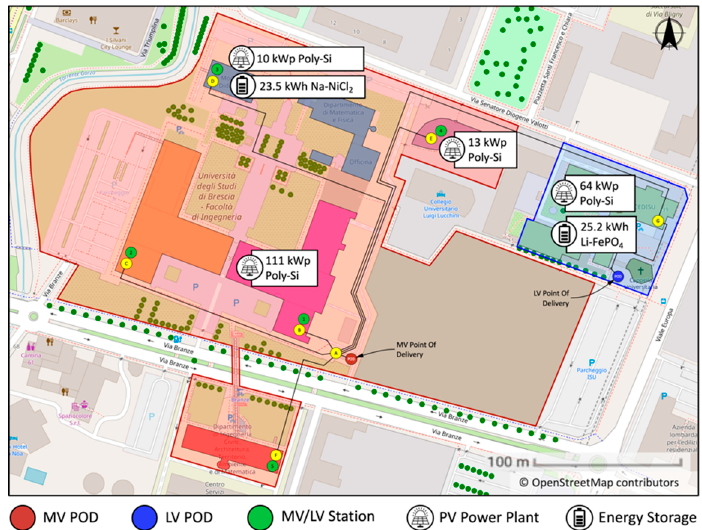
Figure A2. Map of the Engineering campus of the University of Brescia. PV: Photovoltaic, POD: Point of Delivery, MV: Medium Voltage, LV: Low Voltage.